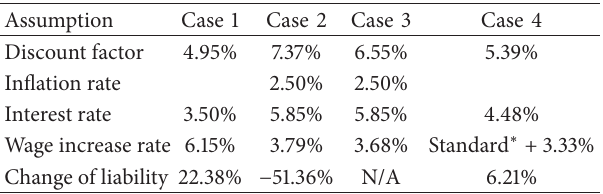
Table 4: Important actuarial assumptions from public